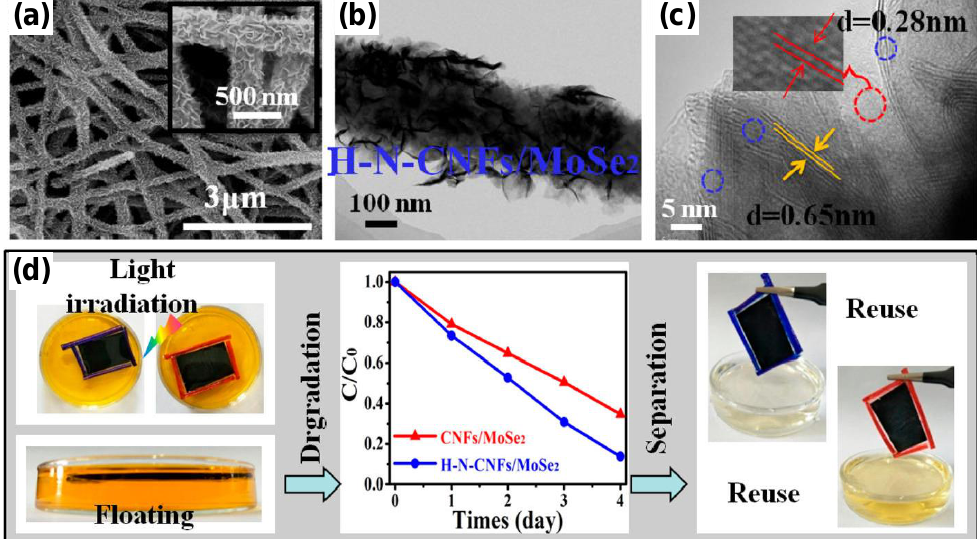
Figure 6. ( a ) SEM images, ( b , c ) Transmission electron microscopy (TEM) images of H–N–CNF / MoSe 2 heterojunctions. ( d ) Digital photographs demonstrating the self-supporting photocatalysis application of H–N–CNF / MoSe 2 and CNFs / MoSe 2 . Adapted with permission from Reference [124]. Copyright (2018) American Chemical Society.